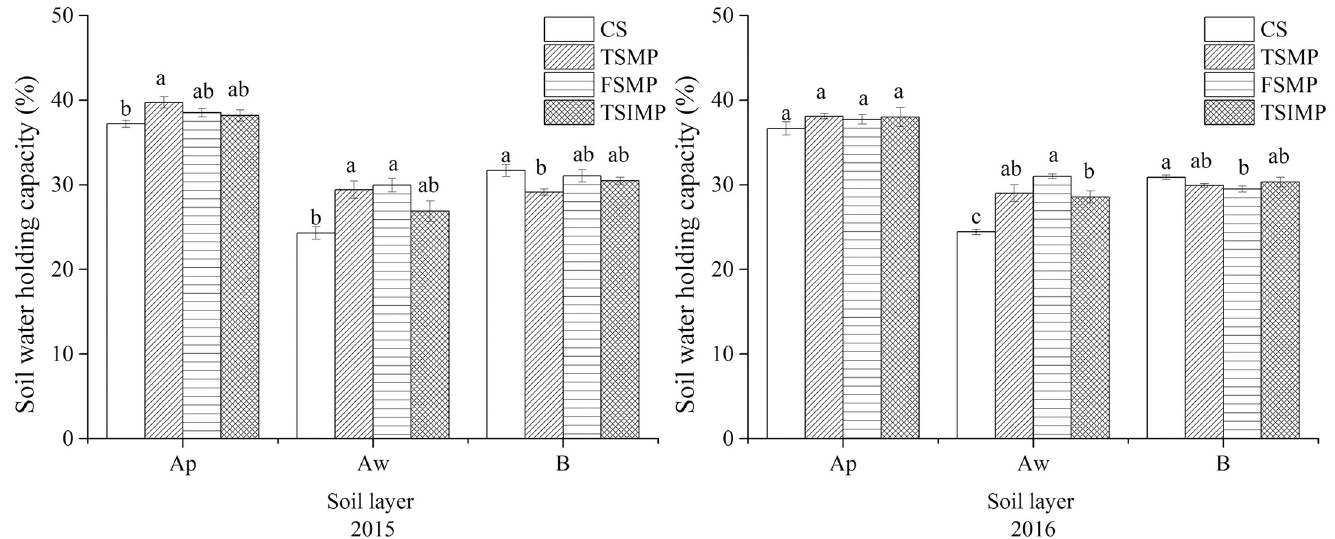
Fig 3. Effects of soil mixing on the soil water holding capacity of Albic soil. Different lowercase letters indicate significant differences between samples ( P < 0.05). Bars represent standard errors (n =